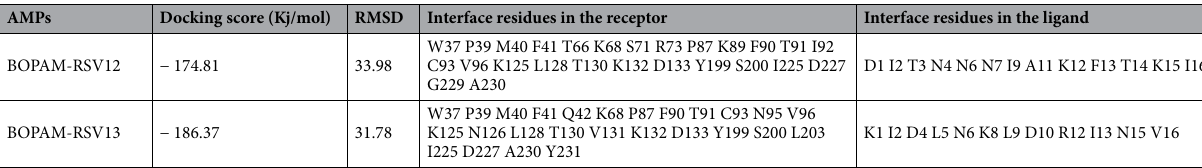
Table 9. Quality assessment scores of the docking analysis from HDock for the anti-pneumonia putative AMPs and the pneumonia receptors with the hotspot interacting